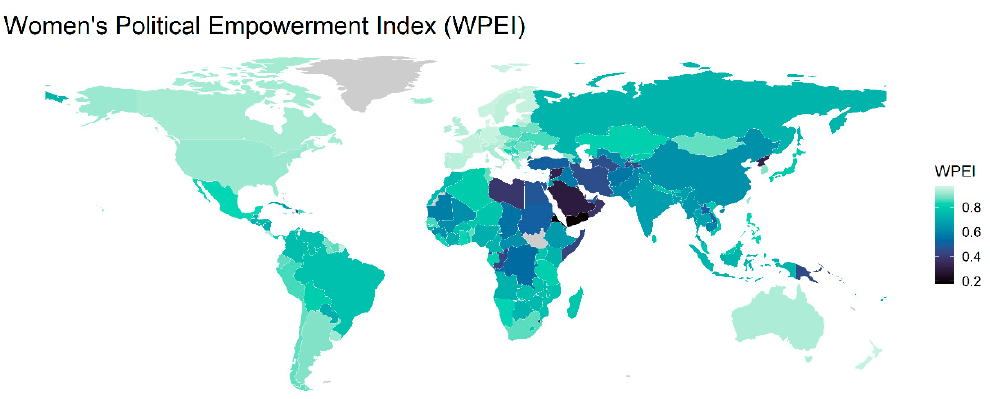
Figure 1. Women’s Political Empowerment Index by country. Dark blue indicates more gender-inegalitarian countries, and light green indicates more gender-egalitarian countries. 5 Source: V-DEM data of the year 2018.